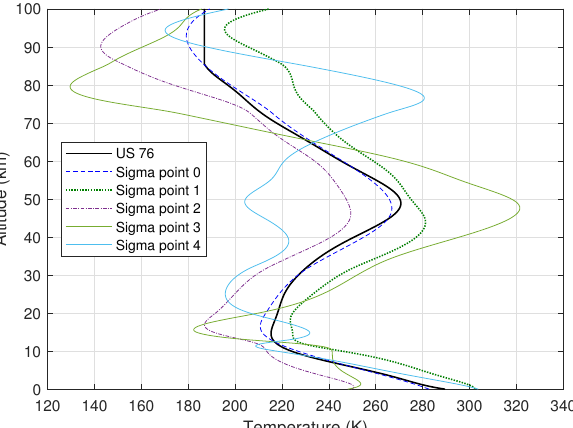
Figure 3. Temperature profiles for the models of each sigma point, and comparison with the US76